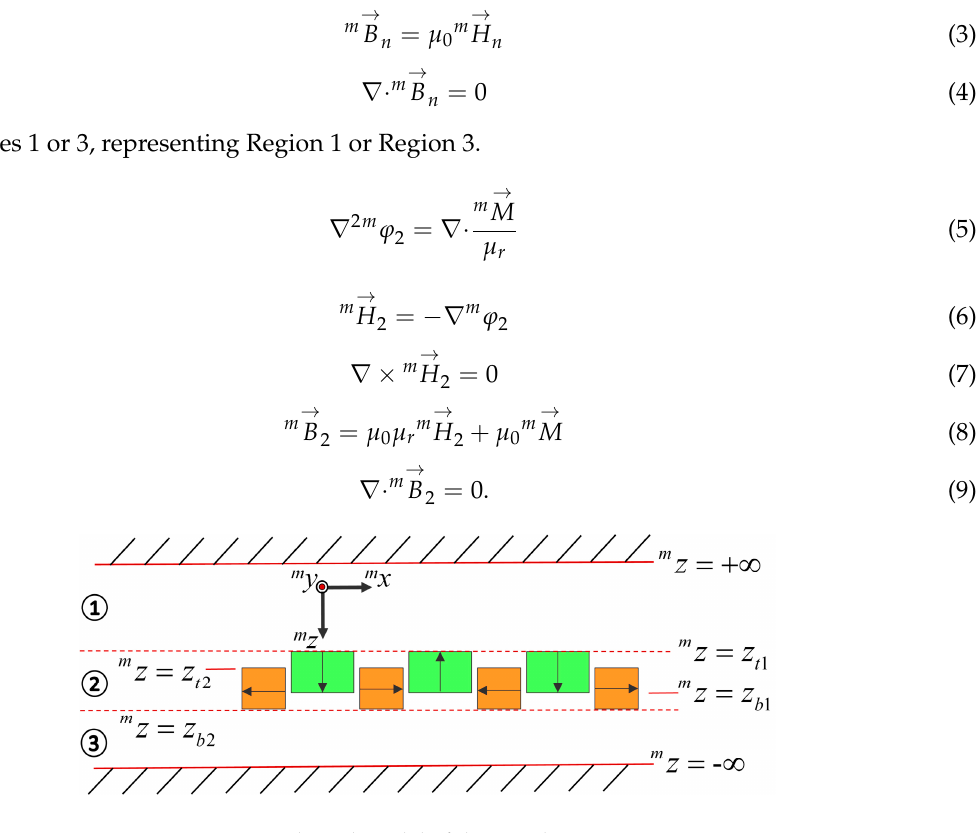
Figure 2. Analytical model of the novel magnet array.